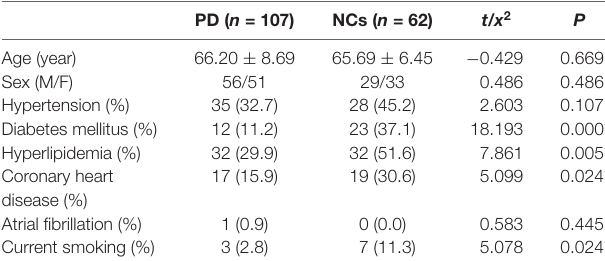
TABLE 1 | Demographic and clinical data of the